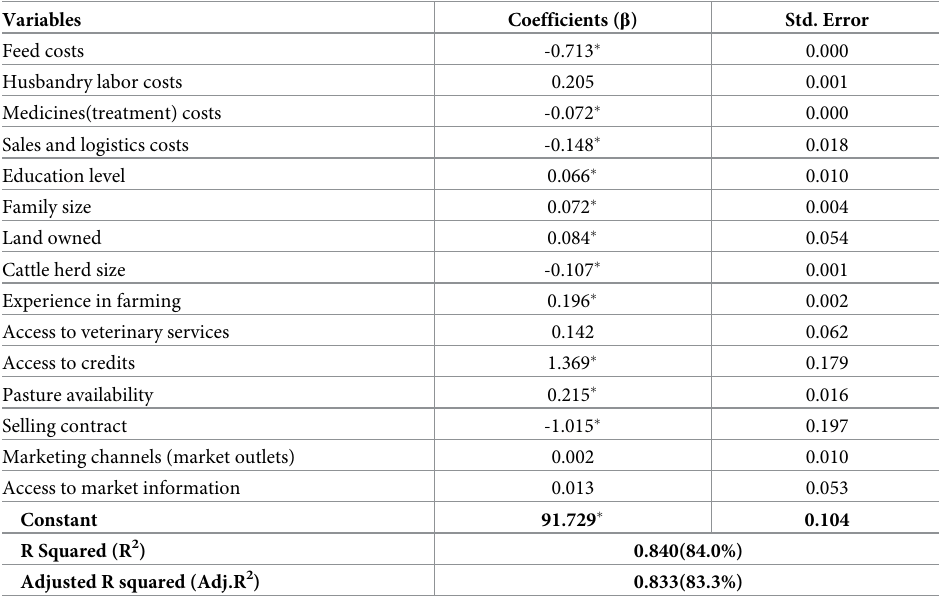
Table 6. Multiple linear regression estimates using ordinary least squares (OLS) on the factors influencing the profitability of beef cattle farming among smallholder beef cattle farmers N = 388). Variables Coefficients ( β ) Std.